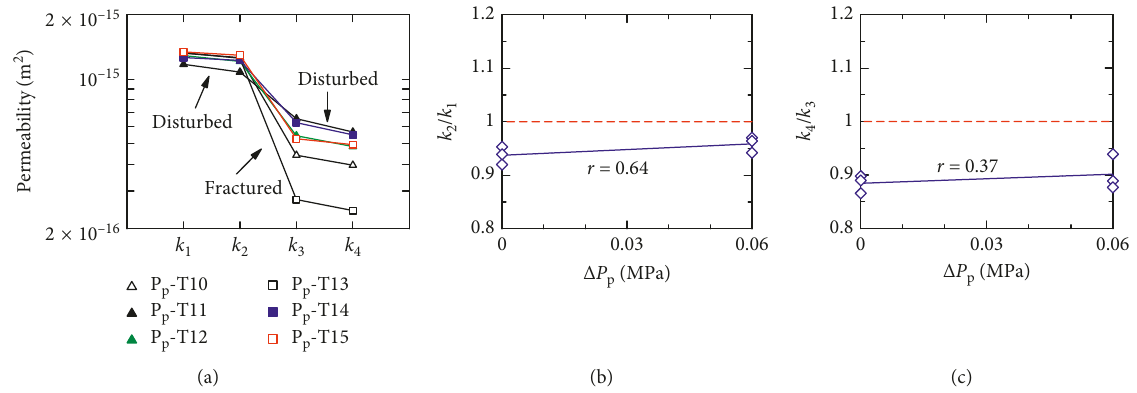
Figure 21: (a) Variation in permeability, and permeability ratios of the intact rocks (b) and the fractured rocks (c) due to transient pore pressure disturbances and triaxial compression of the Shikotsu welded tuff ( P P